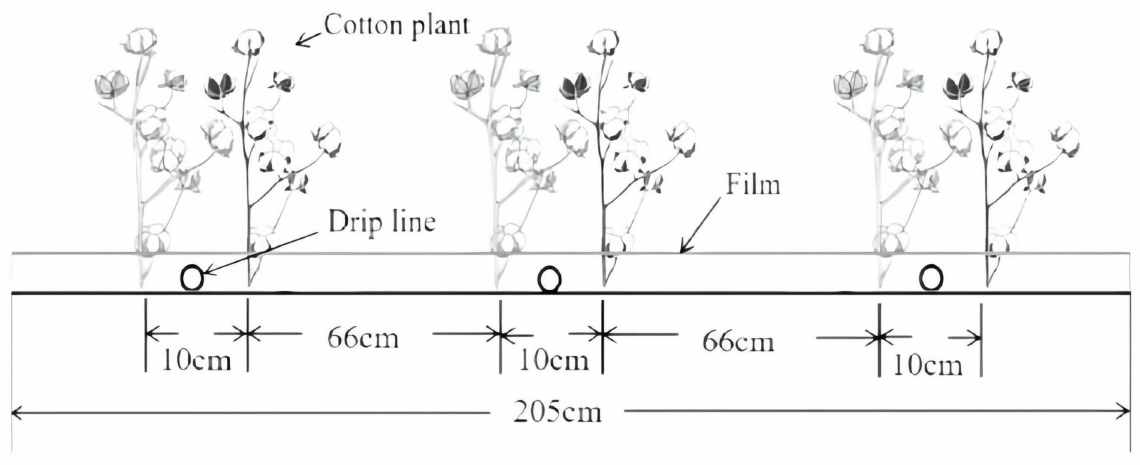
Figure 2. Planting mode of tested cotton under mulched drip